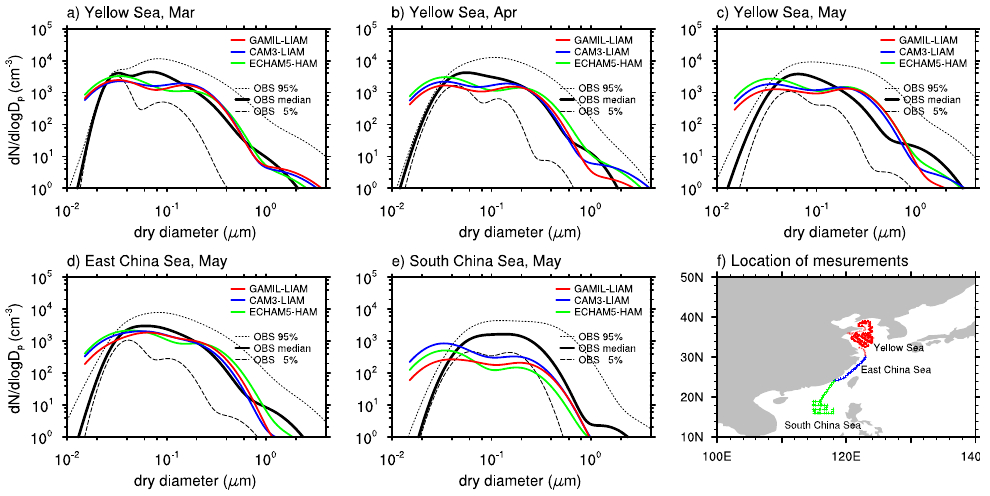
Fig. 13. Comparison between the simulated and observed aerosol size distributions in the marine boundary layer over China adjcent seas. The simulated distributions are the sum of all the modes resolved by the M7 module. The observations were compiled by Lin et al. (2007) (see Table 2